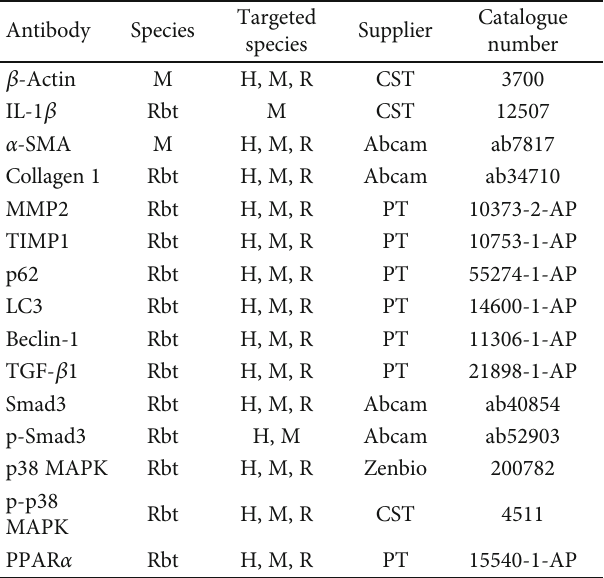
Table 1: The primary antibodies used for western blotting and immunohistochemistry in the